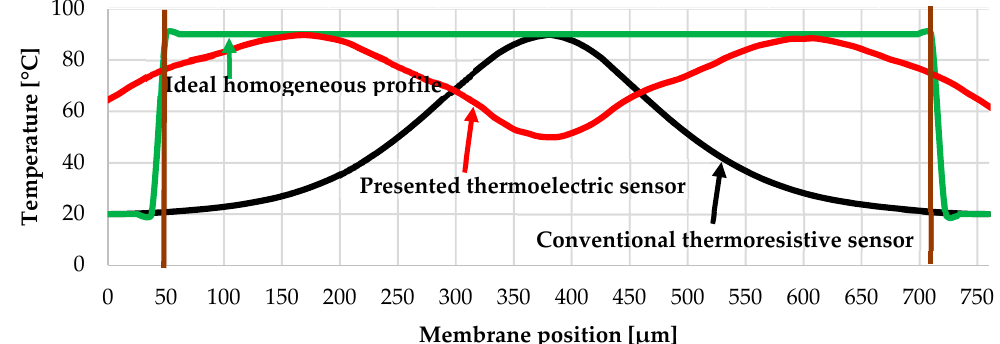
Figure 5. Comparison of the temperature profile (along x-axis through the diameter, 0 µm position starts from the outer periphery of SU8 ring shown in Figure 3a); presented thermoelectric sensor, conventional thermoresistive sensor and ideal homogeneous temperature profile (the red curve is better than the black curve).